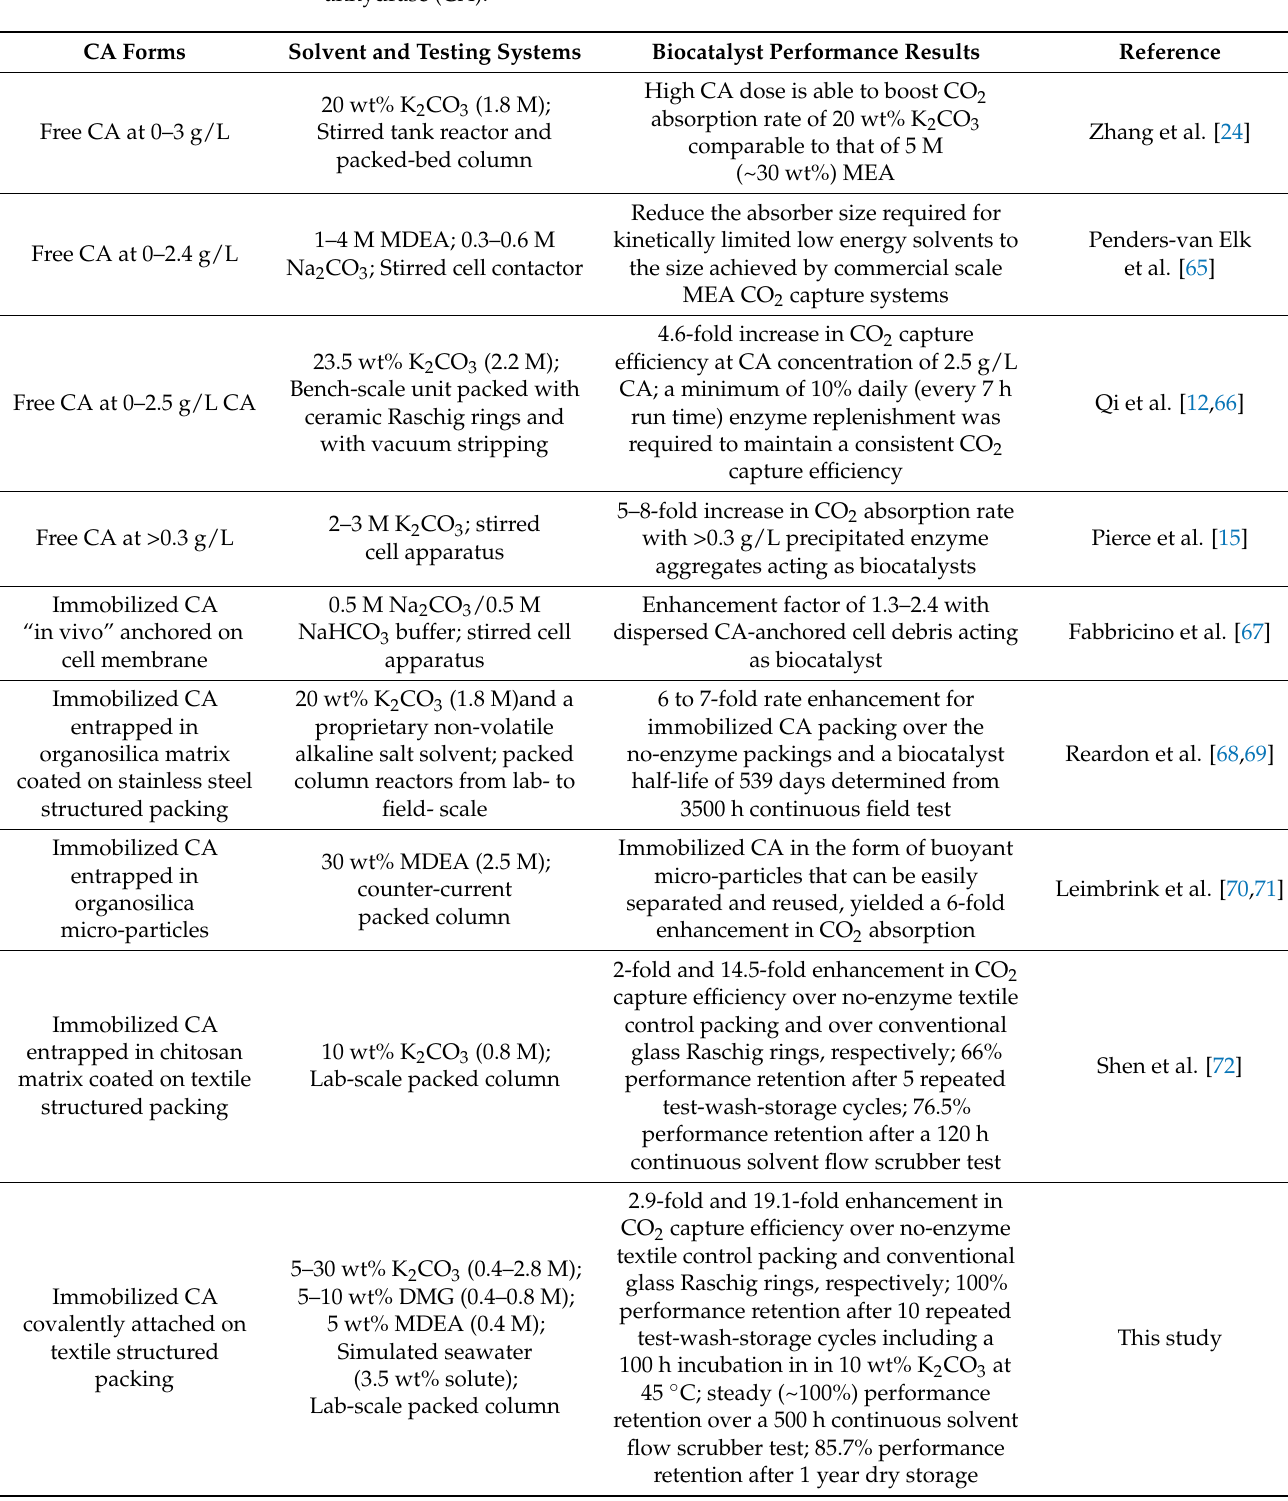
Table 1. Biomimetic CO 2 capture studies using low energy aqueous solutions promoted by carbonic anhydrase